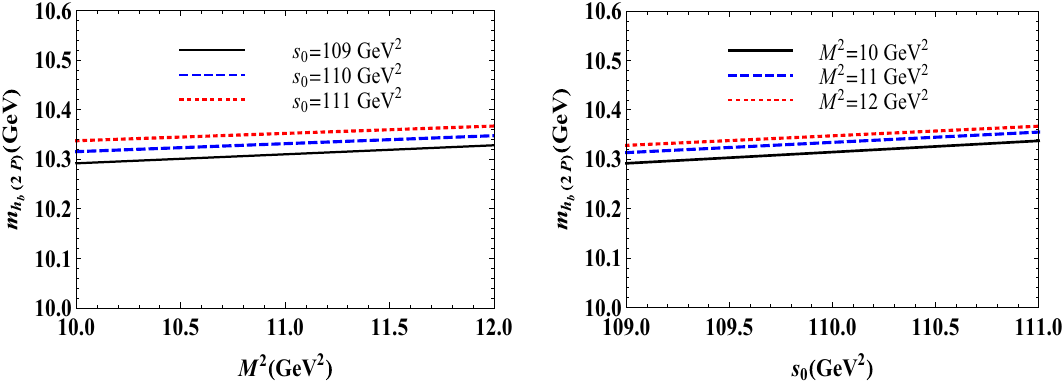
Fig. 3 The mass of the meson h b ( 2 P ) as a function of the Borel parameter M 2 at fixed s 0 (left panel), and as a function of the continuum threshold s 0 at fixed M 2 (right panel)